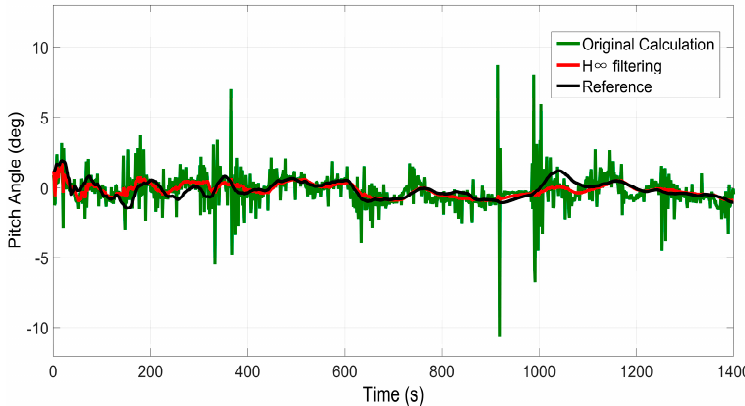
Figure 5. Results of pitch angle estimation in trajectory 1.